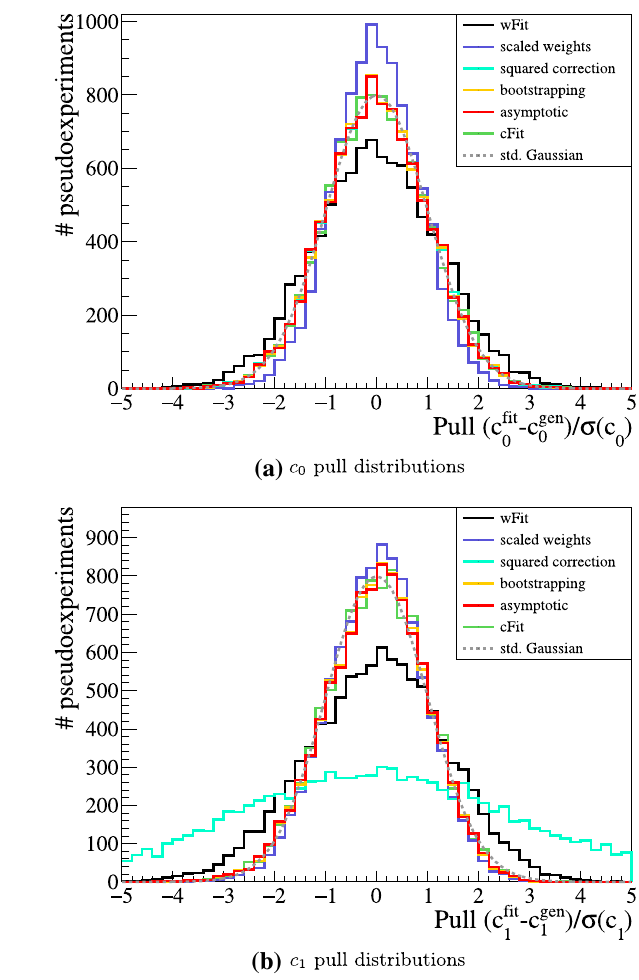
Fig. 3 Pull distributions from 10000 pseudoexperiments for the dif- ferent approaches to the uncertainty estimation for the efficiency cor- rection (cid:4)( cos θ) = 0 . 3 + 0 . 7cos 2 θ at a total yield of 2000 events